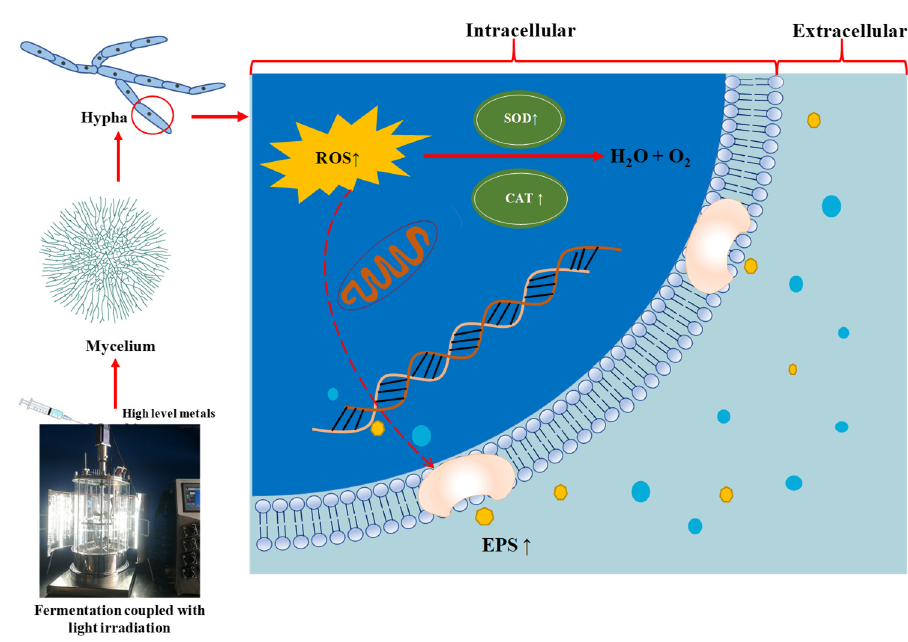
Figure 8. The postulated regulatory mechanism of LED-lights irridation coupled with metal ions on mycelia growth and EPS accumulation by A. sinodeliciosus var. Chaidam ZJU-TP-08 . Table 2. Repression of up-regulated genes involved in oxidative stress.